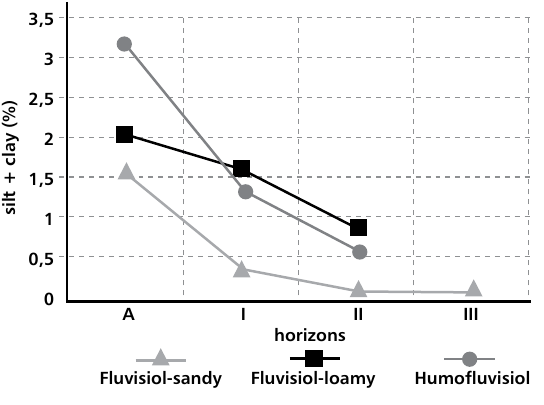
Humus distribution per profile